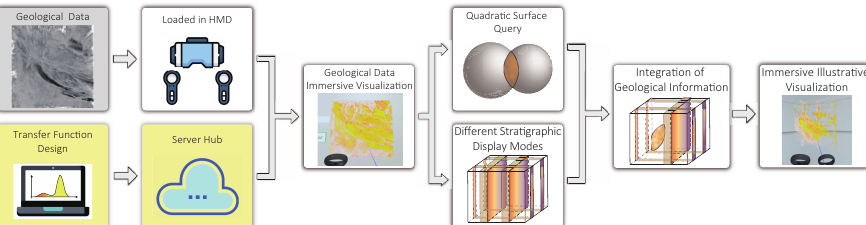
Figure 1. Our proposed tool consists of three steps. Firstly, the preprocessed data are imported into the immersive device, and the transfer function (TF) is imported into the HMD through the cloud server. Then the geological volume data are rendered on GPU by volume rendering. Different types of interaction can be performed on slice data, or UFP can be further extracted by the quadratic surface- based query. Different stratigraphic display patterns or any combination of them can be obtained. Finally, all the illustrative results can be mixed to better reveal the structure and UFP